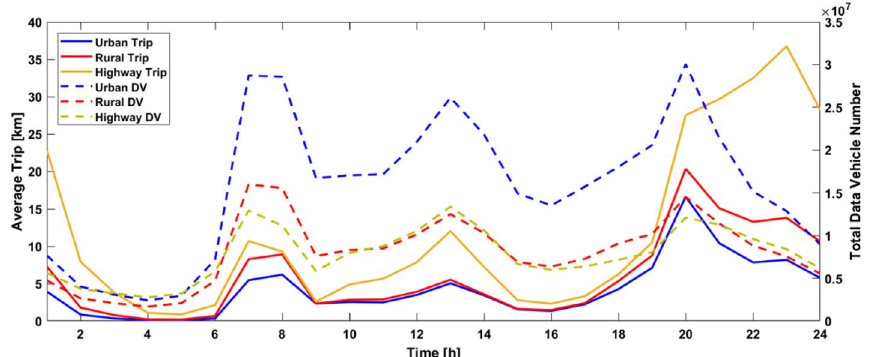
Fig. 4 Distribution of average trip and DV number per hour according to Istanbul road